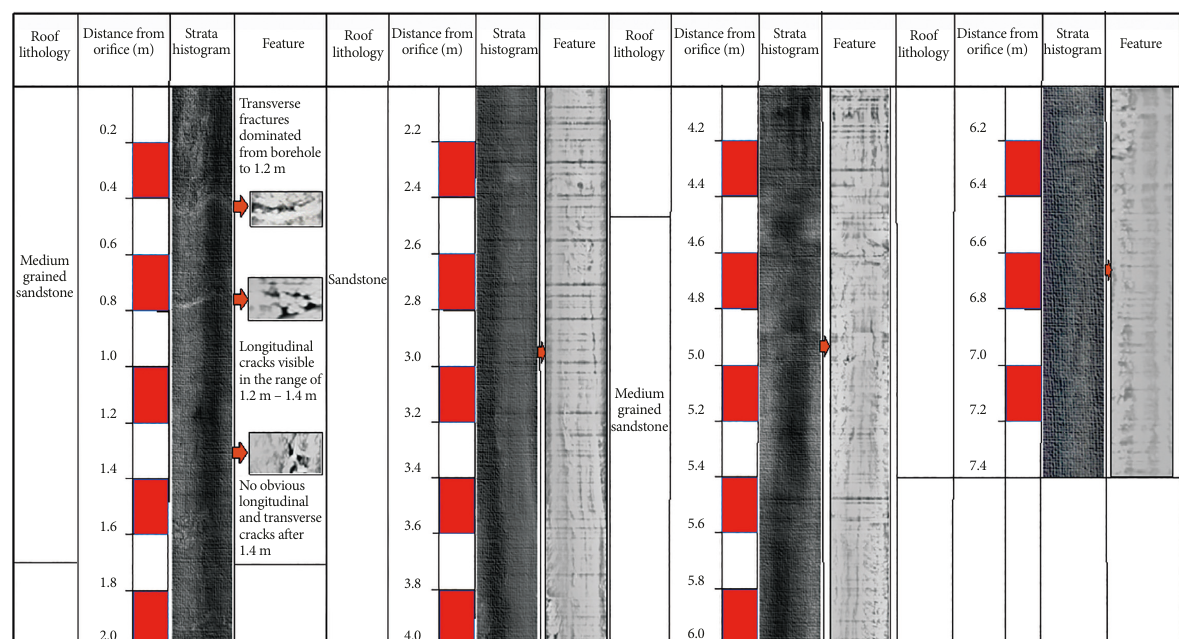
Figure 6: Loose ring development in the roof of the roadway.